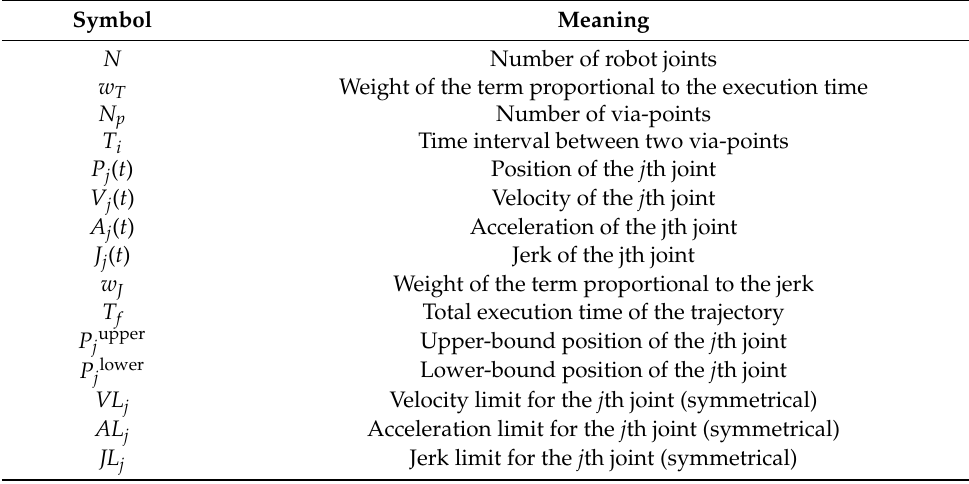
Table 2. Meaning of the symbols in Equation